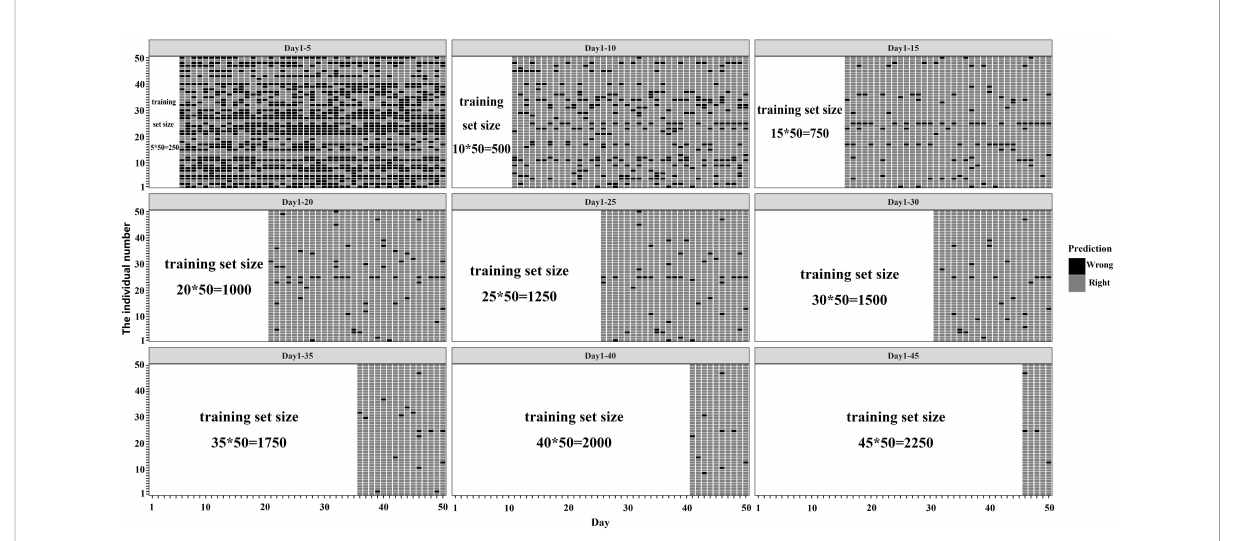
FIGURE 5 The result of tracking recognition of P. leopardus on different time